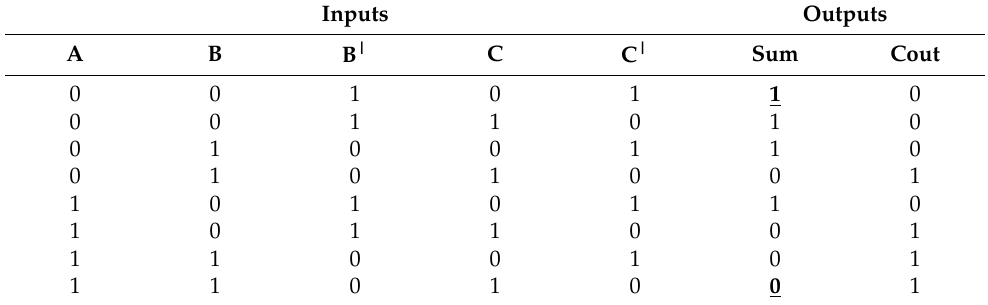
Figure 6. Proposed 10T AA design. Table 3. Proposed 10T AA truth table.